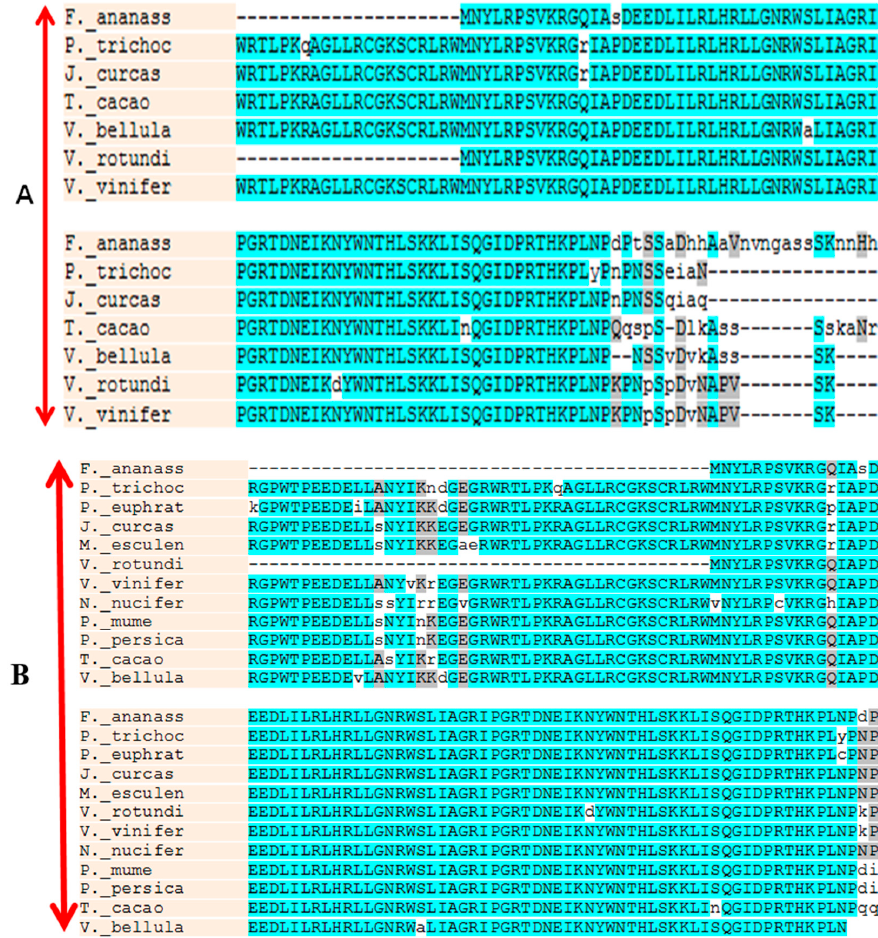
Figure 3. Amino acid sequence alignment of MybA1 ( A ); and MYBCS1 ( B ) proteins from different plant species. Residues highlighted in blue represent identical and similar amino acids, respectively. The alignment was performed using multi-align software as defined in the Materials and Methods section.